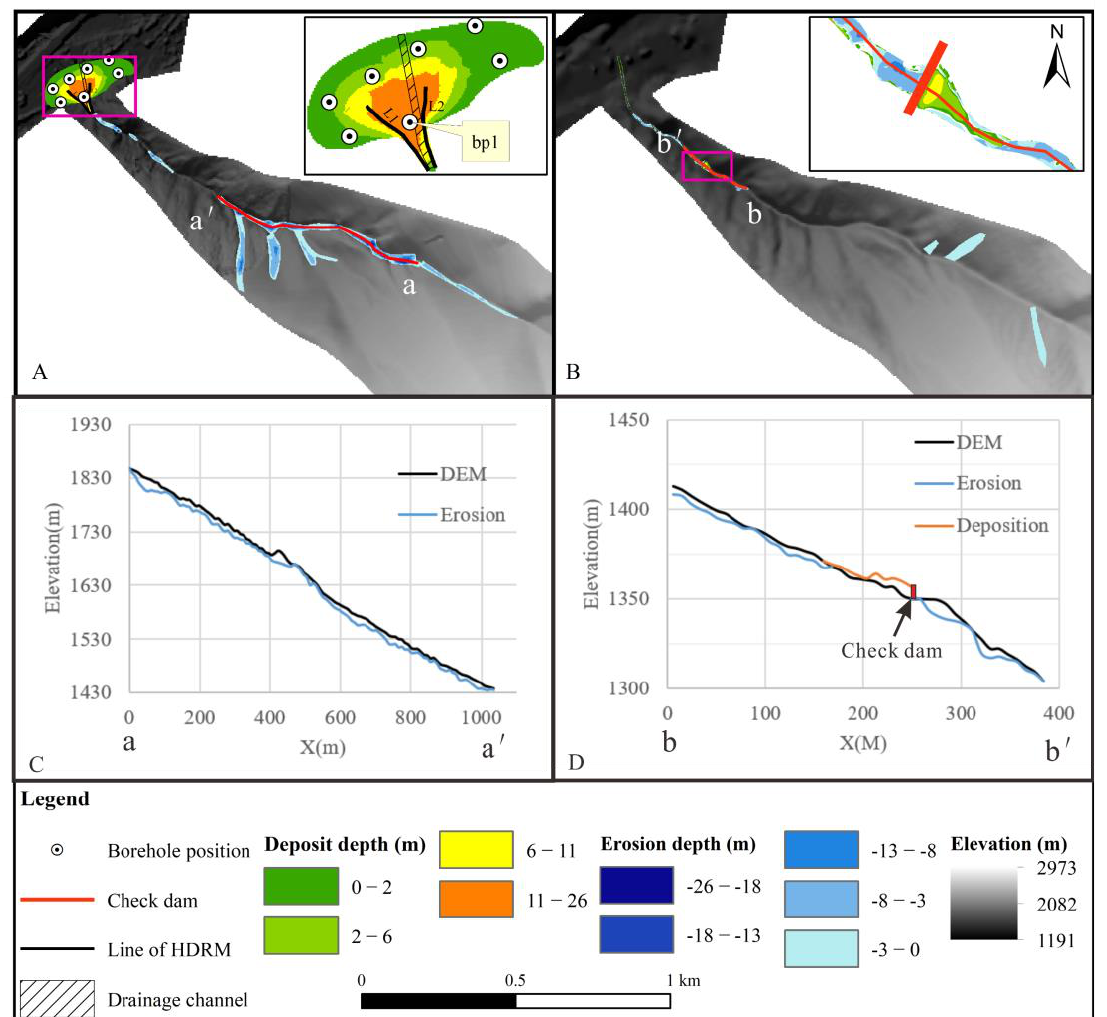
Figure 4. ( A , B ) The depth distributions of eroded debris and deposited debris in the 2013 debris flow event and the 2020 debris flow event, respectively. ( C , D ) The longitudinal profiles along the channel, and their positions are shown in A and B, respectively. The location of profiles a-a’ is shown in ( A ) and the location of profile b-b’ is shown in (B).